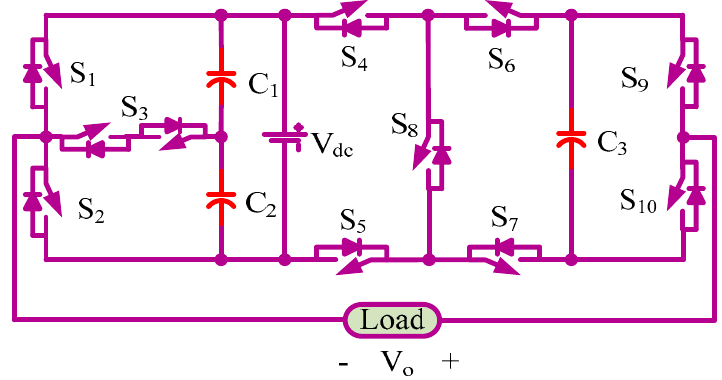
Figure 1. Nine-level switched capacitor MLI for a phase.